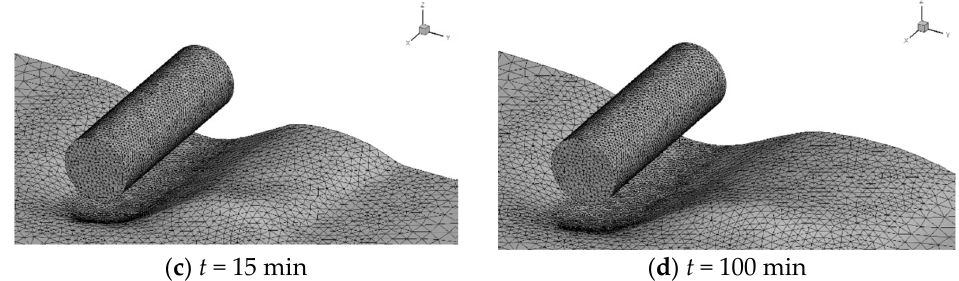
Figure 11. Development of the bed shape for L = 6 D.